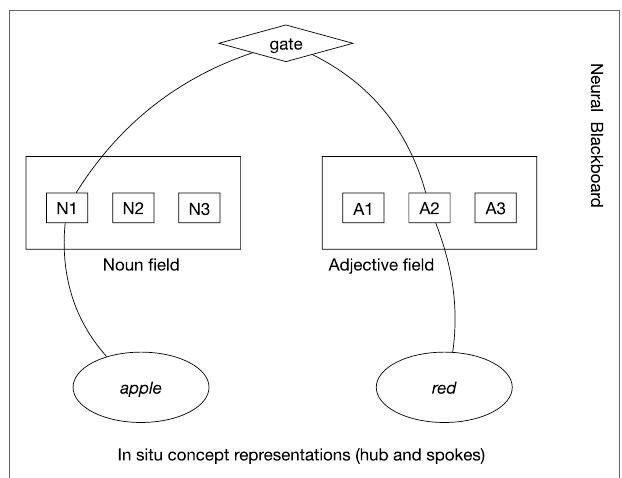
FigUre 1 | In situ representation of red apple by a connection path between in situ concept representations in a neural blackboard architecture. The noun apple first binds to a Noun assembly (here, N1) in the Noun field of the neural blackboard and red binds to an Adjective assembly (here, A2) in the Adjective field. The connection path passes through gates, which provides control to represent relations. Here, activation of “gate” gives adjectives bound to nouns, here red to apple